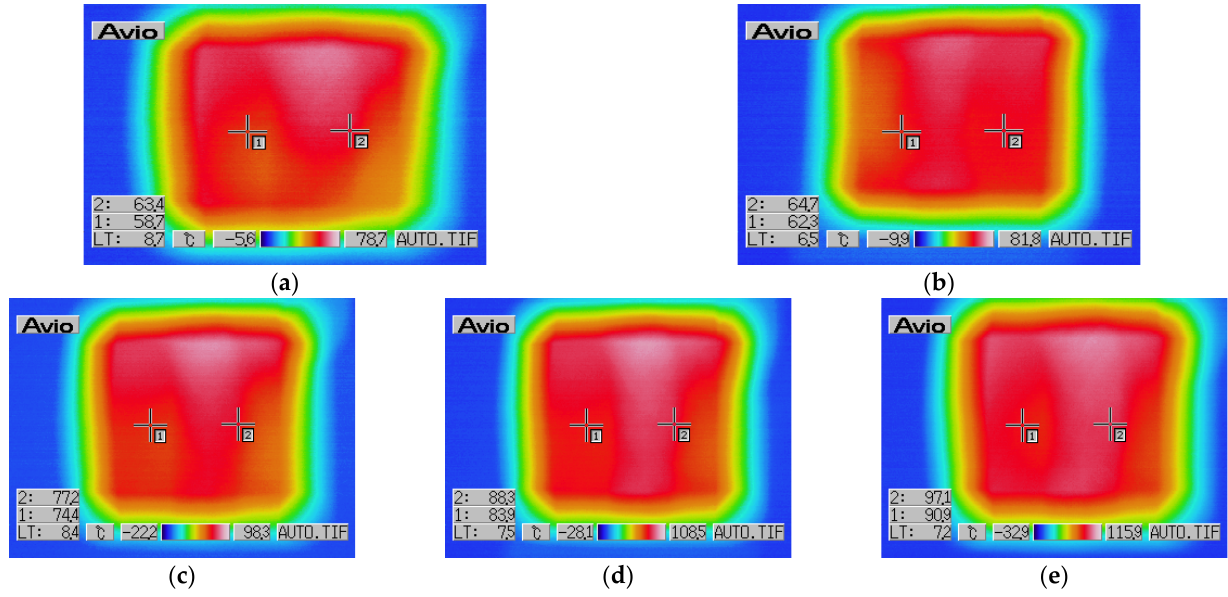
Figure 9. Heat distribution map of C1.1: ( a ) 15 min; ( b ) 30 min; ( c ) 45 min; ( d ) 60 min; ( e ) 75 min.